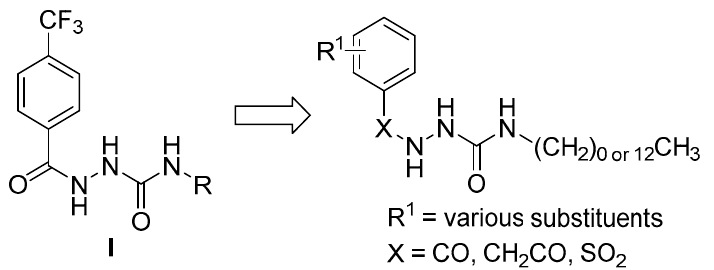
Figure 1. Design of novel cholinesterase inhibitors.